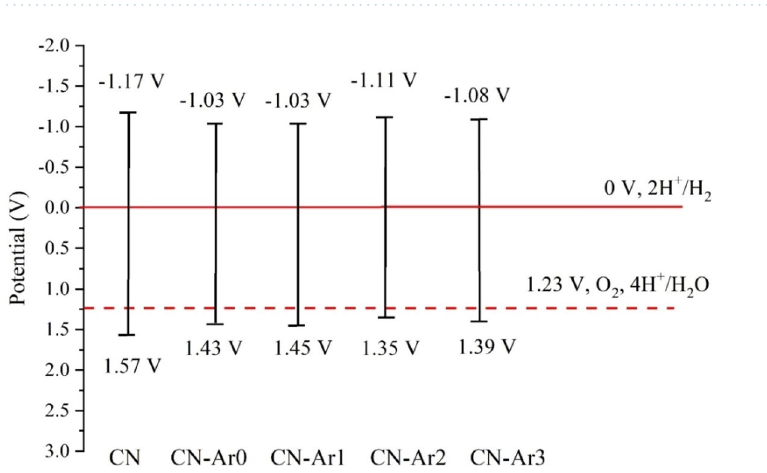
Figure 10. Energy diagram of conduction and valence band potentials of CN and CN-Ar materials at pH =